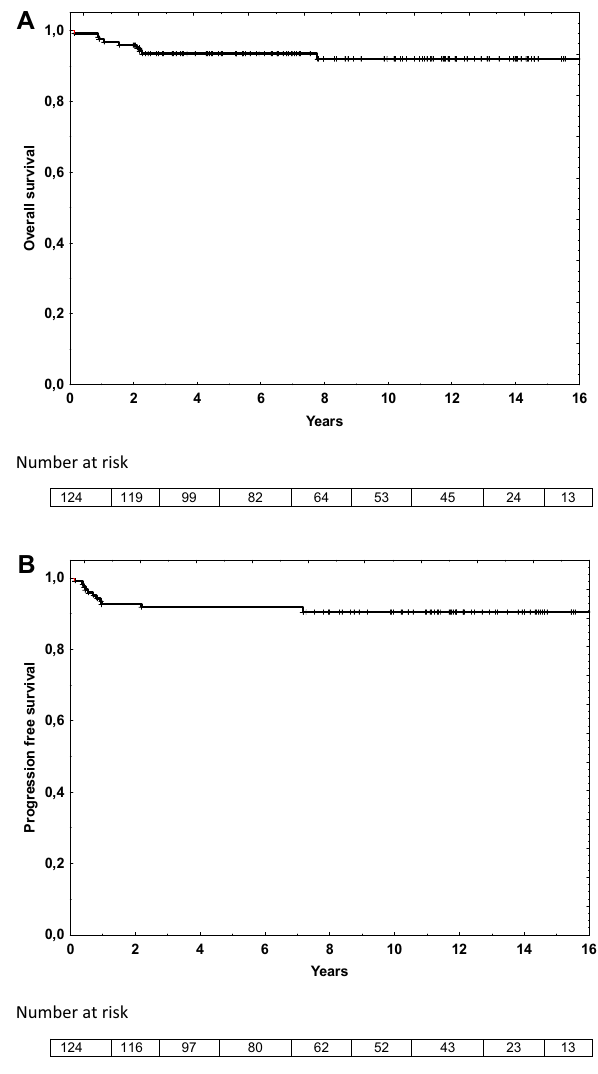
Figure 2. Outcomes based on Kaplan–Meyer analysis: overall survival ( A ) at 5 year was 94% (95% CI 90–98%) and progression free survival ( B ) at 5 year was 92% (95% CI 88–96%). Median follow up 8.5